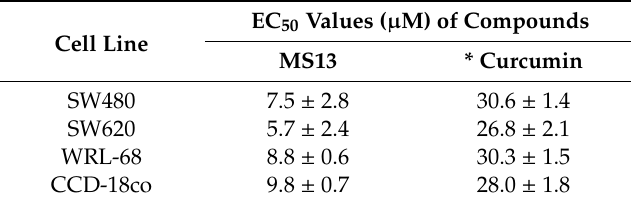
Table1. EC 50 valuesofMS13andcurcuminoncoloncancer(SE480andSW620)andnormal(WRL-68and CCD-18co) cells.